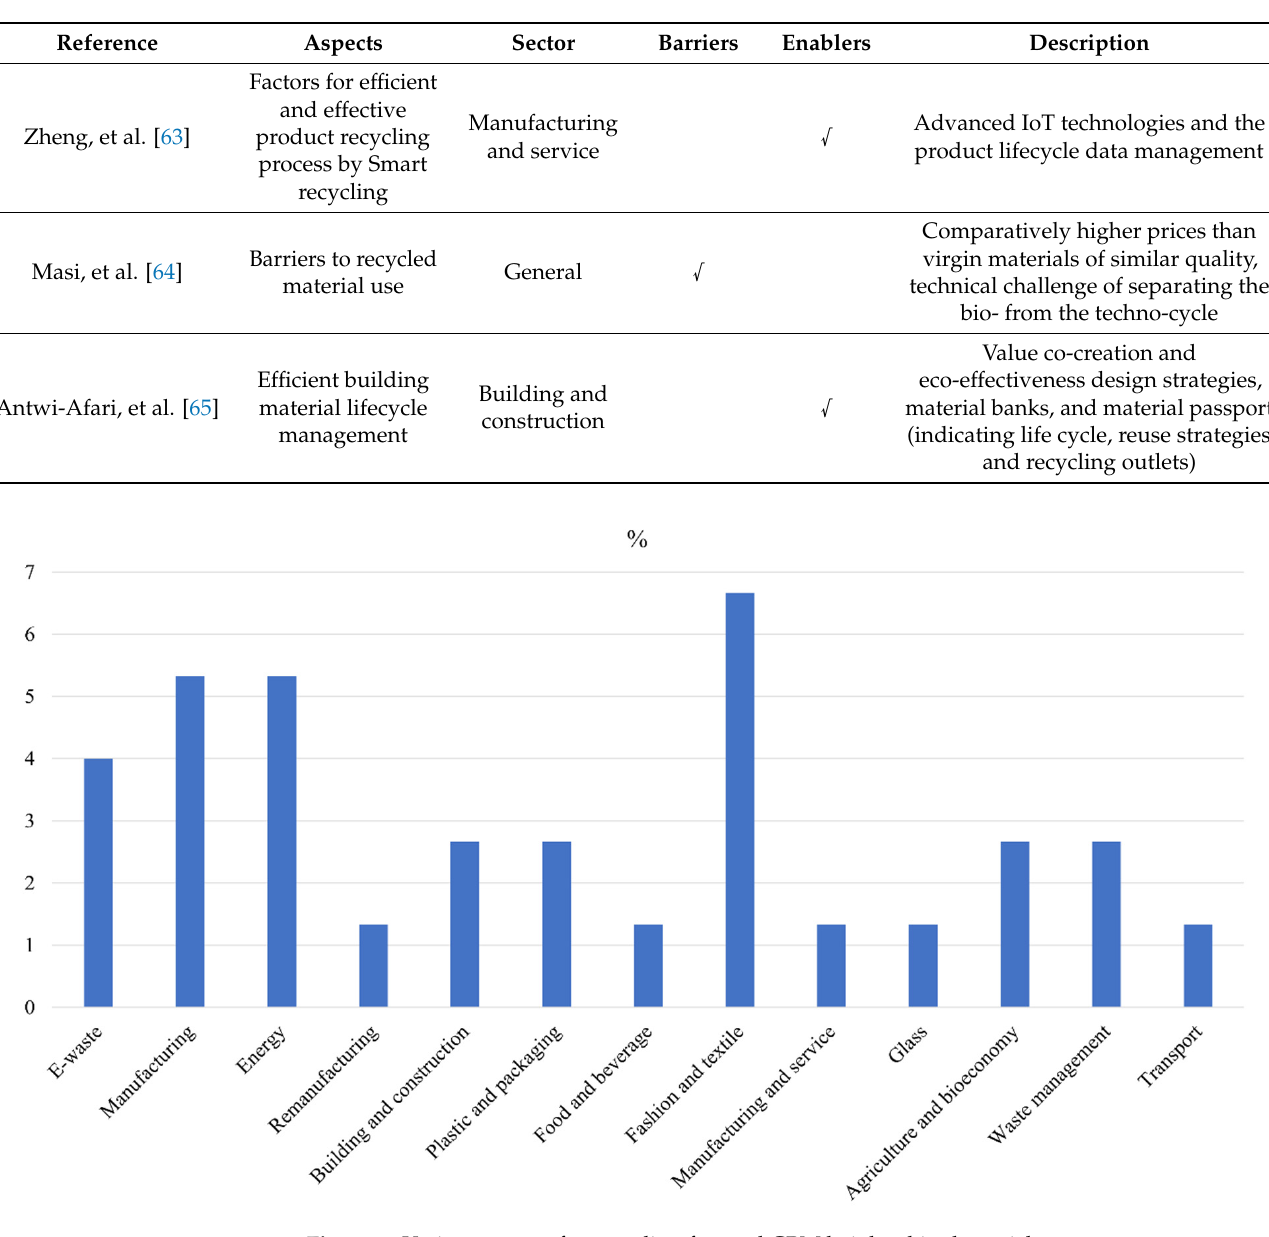
Figure 6. Various sectors for recycling focused CBM heighted in the